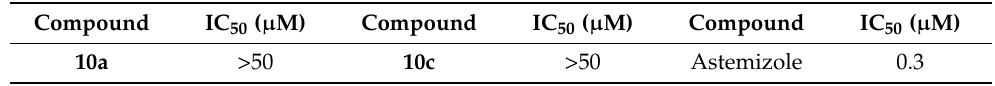
Table 8. IC 50 of compounds 10a and 10c in hERG